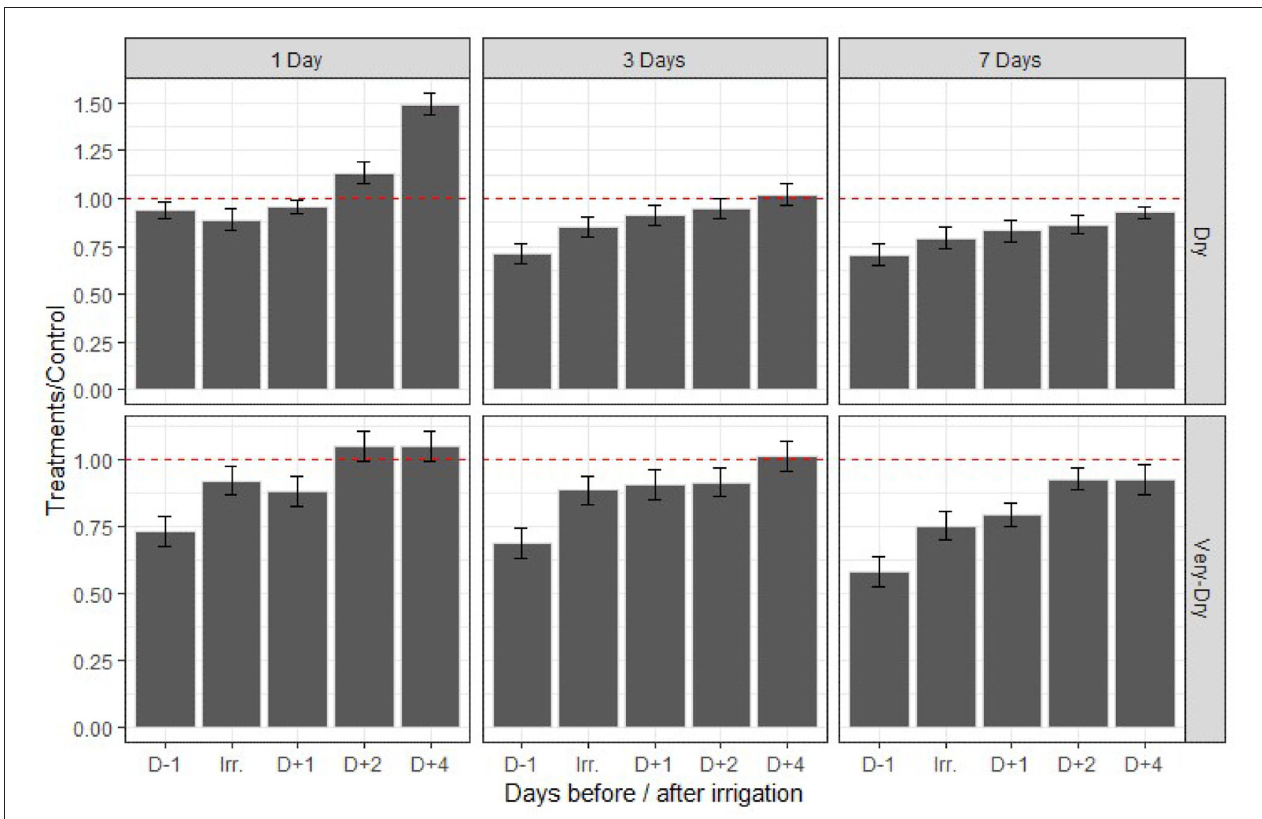
FIGURE 4 | Variation of relative quantum yield as a function of time and stress treatments for the summer 2019 experiment. The error bars represent the standard deviation around the mean for the four replicates of a same treatment. The red dashed line ( —-) represents the threshold from which the recovery of the treatments is complete compared to the control measured at the same time. The values above the red dashed line represent an increase in quantum yield of treatments compared to the control and those below a deficiency. D − 1, D+1, D+2, D+3, D+4 on the X axis represent the number of days before ( − ) and after (+) application of irrigation. Irr is the day that irrigation is